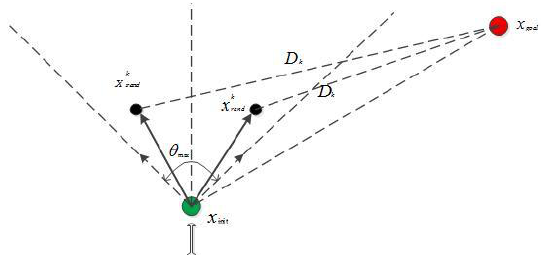
Figure 4. Selection of random point